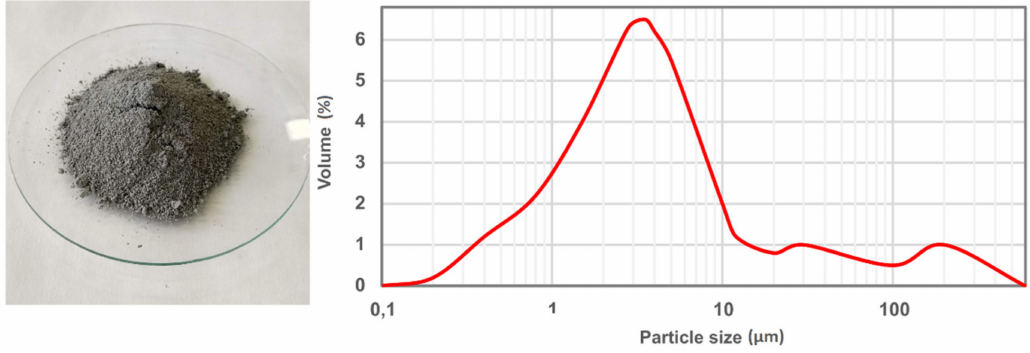
Figure 2. Copper furnace dust sample ( left ) and particle size distribution ( right ) [10].